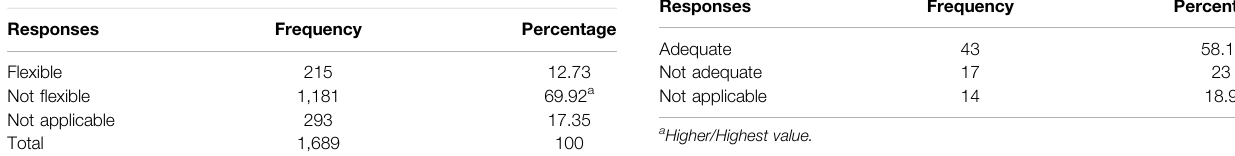
learning among students (n (cid:1) 1,689).